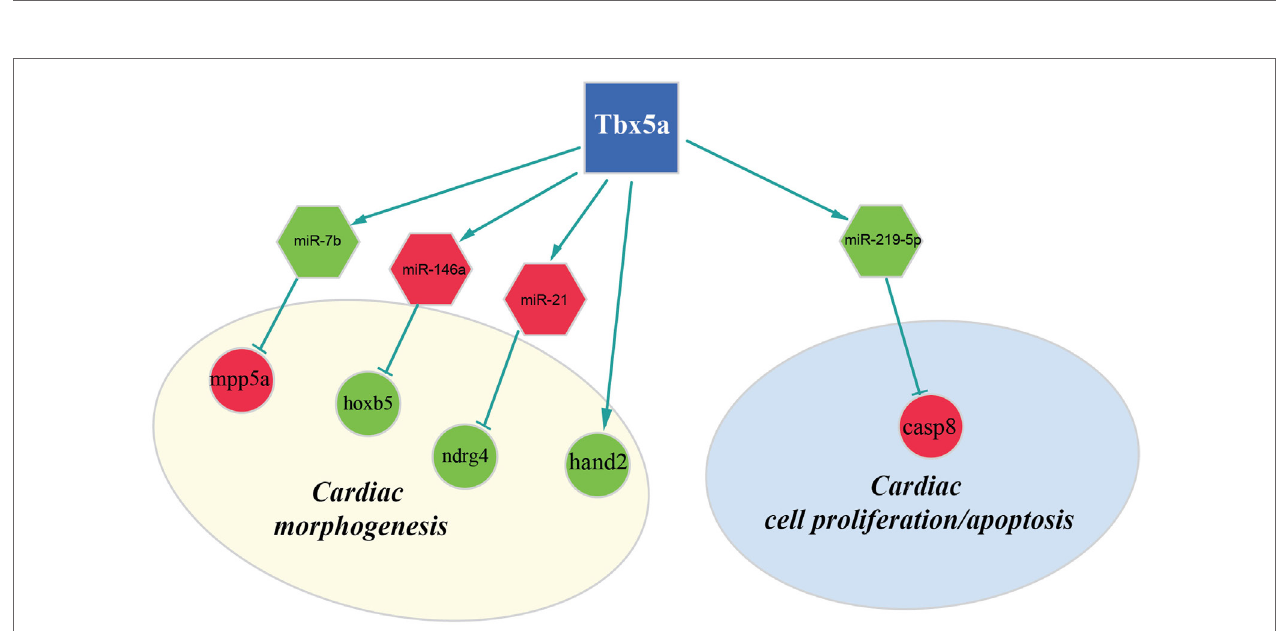
FigUre 3 | regulatory network altered in zebrafish hOs model at 24 hpf . Potential interactions involving Tbx5, transcriptional factors, miRNAs, and their targets are shown together with the functional impact in heart